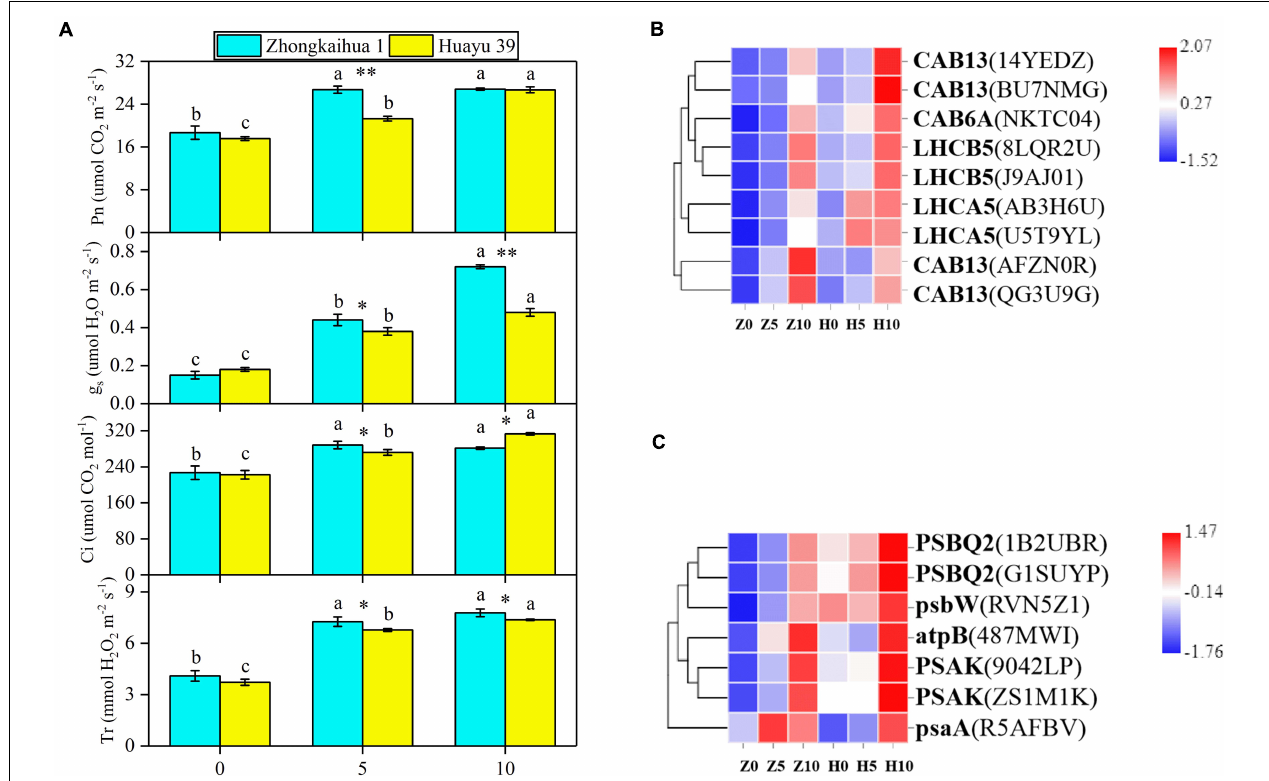
FIGURE 6 | Effects of waterlogging on photosynthesis metabolism. (A) Effects of waterlogging stress on the photosynthetic parameters of peanut. Data represent the mean ± standard error. Measurement was conducted on the leaves of the main stem after treatment. Letters a and b after the value represent statistically significant differences ( p < 0.05) within a variety under different waterlogging treatments as determined by the least significant difference test. Significant differences at * p < 0.05 and ** p < 0.01 between Zhongkaihua 1 (ZKH 1) and Huayu 39 (HY 39) under the same treatment. 0, 5, and 10 represent without waterlogging, waterlogging for 5 days, and waterlogging for 10 days, respectively. (B) Expression patterns of the differentially expressed genes (DEGs) induced by waterlogging stress in the photosynthesis–antenna proteins pathway. The color in the heat map represents the Z-score after the transformation of log2(mean FPKM). Each row in the heat map represents the levels of a DEG under different conditions. The DEG name and the gene ID in parenthesis were listed on the right side of the heat map. Abbreviations for DEGs encoding proteins: CAB13, light-harvesting chlorophyll B-binding protein 3; CAB6A, light-harvesting chlorophyll B-binding protein 3; LHCB5, light-harvesting chlorophyll B-binding protein 3; LHCA5, light-harvesting chlorophyll B-binding protein 3. Expression change of DEGs with at least twofold changes and p < 0.05 in the porphyrin and chlorophyll metabolism pathway. The expression levels were calculated in fragment per kilobase per million reads (FPKM) from triplicate experiments. The heat map shows the normalized value Z-score after log2(FPKM) transformation. (C) Expression patterns of the DEGs induced by waterlogging stress in the photosynthesis pathway. Expression change of DEGs with at least twofold changes and p < 0.05 in the porphyrin and chlorophyll metabolism pathway. The expression levels were calculated in fragment per kilobase per million reads (FPKM) from triplicate experiments. The heat map shows the normalized value Z-score after log2(FPKM) transformation. The color in the heat map represents the Z-score after the transformation of log2(mean FPKM). Each row in the heat map represents the levels of a DEG under different conditions. The DEG name and the gene ID in parenthesis were listed on the right side of the heat map. Abbreviations for DEG encoding proteins: PSBQ2, oxygen-evolving enhancer protein; psbW, photosystem II reaction center W; atpB, ATP synthase, F1 beta subunit; PSAK, photosystem I reaction center subunit X psaK; psaA, photosystem I P700 chlorophyll A